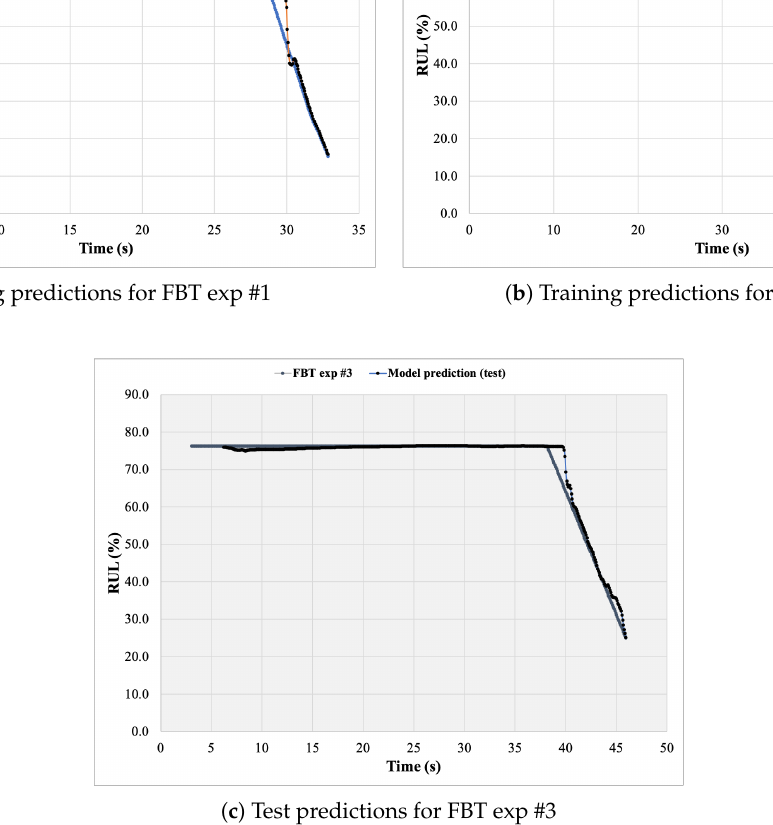
Figure 11. RUL predictions of the deep learning model trained on FBT Experiments 1 and 2 and tested on FBT Experiment 3. The gray background in ( c ) conveys that the digital twin was tested on this FBT